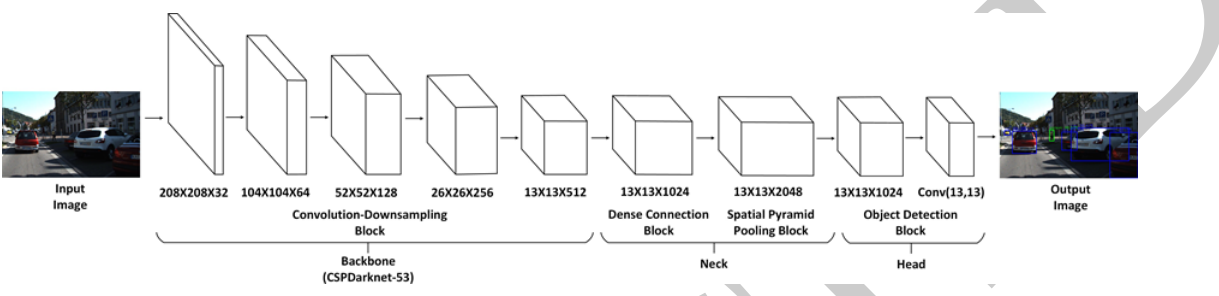
Figure 6. The architecture of the You Only Looks Once v4 (YOLOv4) [30].